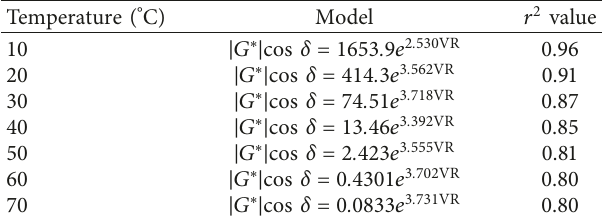
G cos δ and VR for the stone | | ∗